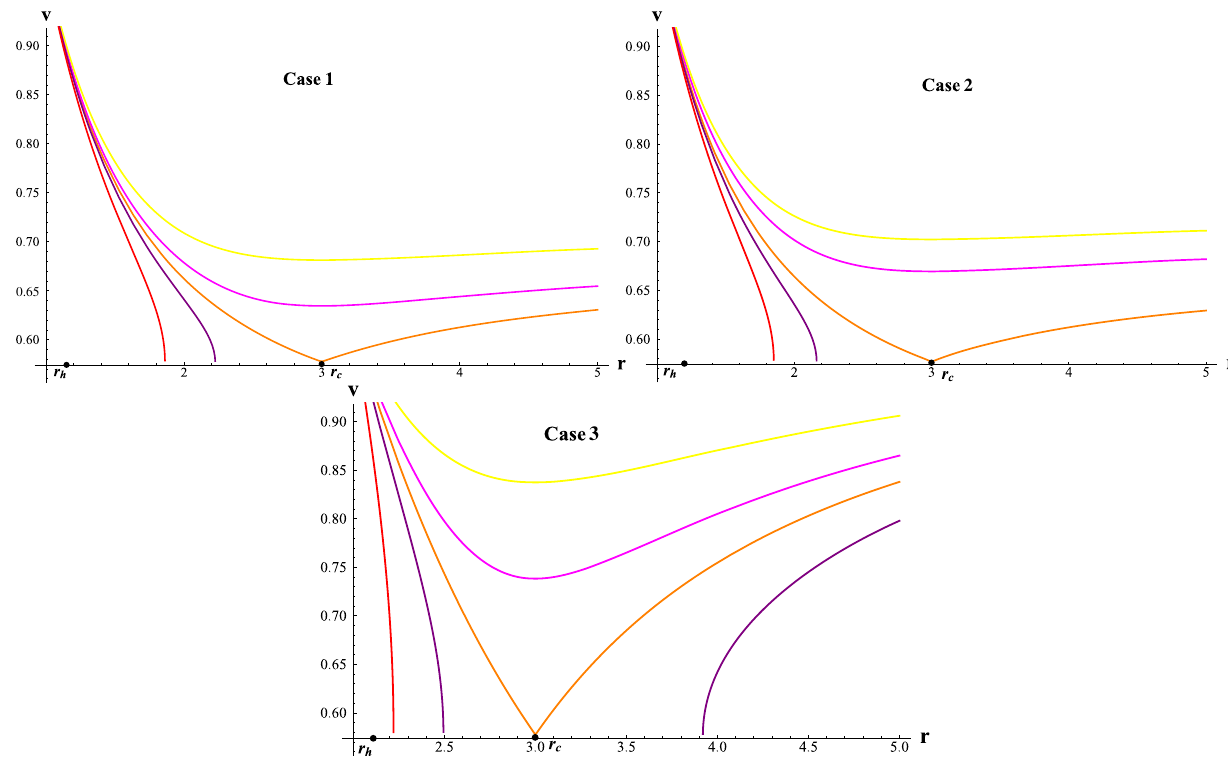
v = 0 . 5773, H ≈ 1 . 93626. Bottom panel (Schwarzschild BH) dis- c c plays the behavior of (42) with Schwarzschild BH parameters γ = 0, k = 0, β = 1. The critical parameters involve r c = 3, v c = 0 . 5773, H c ≈ 0 . 20998. The representation of colors in H = H c → orange, H > H c → magenta and yellow, H < H c → purple and